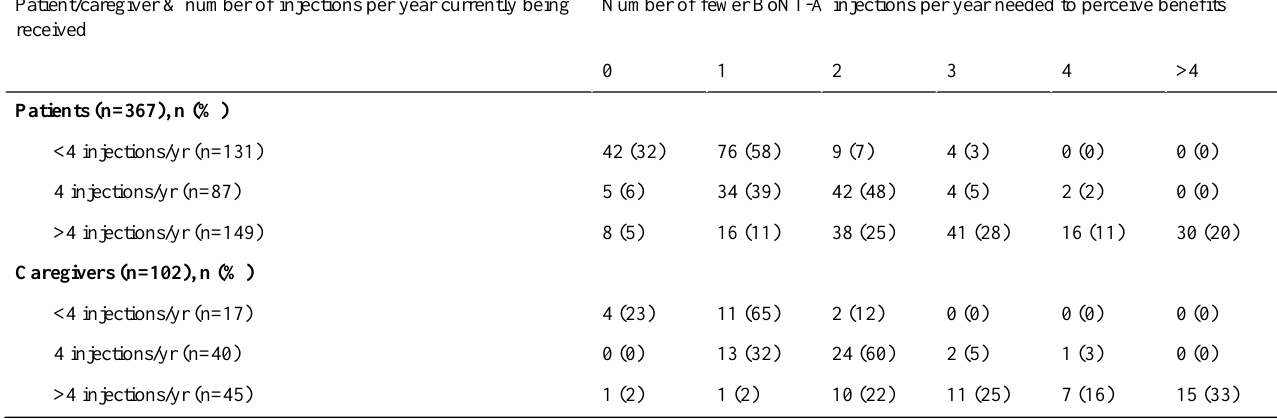
Table 5. Expected reduction in the number of botulinum neurotoxin type A (BoNT-A) injections per year to achieve perceived benefits for patients and caregivers, according to the number of injections currently being received ("Assuming the effect of botulinum toxin A injections could last longer, with how many injections per year would you feel the benefit of less frequent